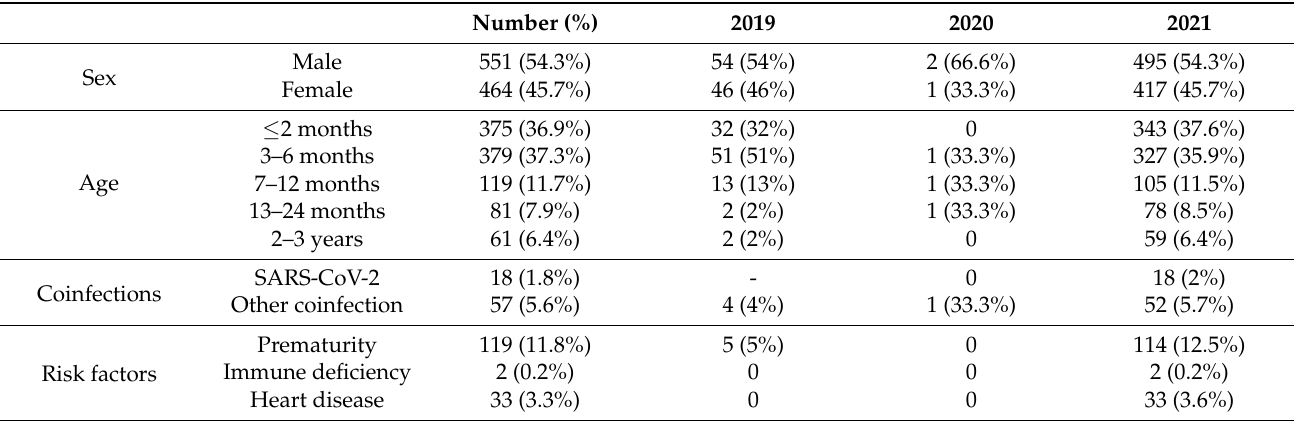
Figure 2. Weekly test results for RSV, influenza and SARS-CoV-2 during the study periods of 2019 and 2021 at the major regional Pediatric Hospital (Regina Margherita Children’s Hospital, Turin). Data from 2020 were excluded considering the extremely low number of positive cases. RSV: Respiratory Syncytial Virus; Flu: influenza virus; SARS-CoV-2: Severe Acute Respiratory Syndrome Coronavirus 2. Demographic and epidemiological characteristics of the total population are summa- rized in Table 2. Table 2. Demographic and epidemiological characteristics of the cohort.